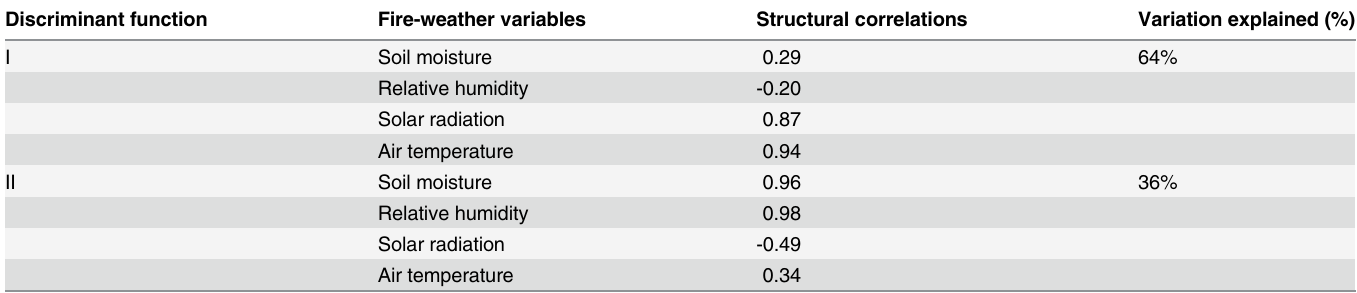
Table 1. Results of discriminant analysis showing the relationships between two discriminant functions and four variables describing fi re weather conditions over 13 years (1997 – 2009) at the Avon Park Air Force Range, south-central Florida (USA). Discriminant